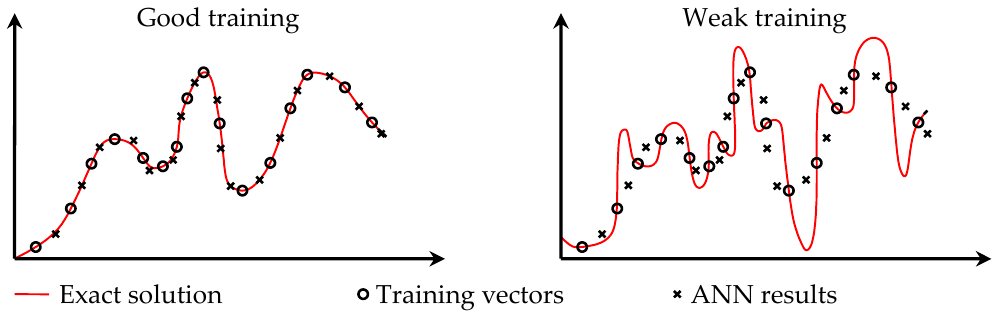
Figure 4. Example of the influence of the ANN training in the output results.